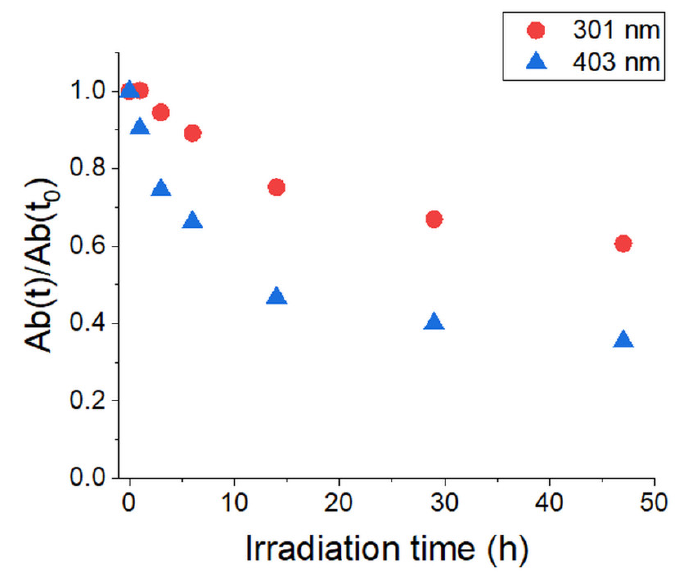
Figure 12. Normalized UV-Vis absorption of Poly(ProDOT)-Poly(MM) at 301 nm and 403 nm during AM 1.5 G light irradiation.